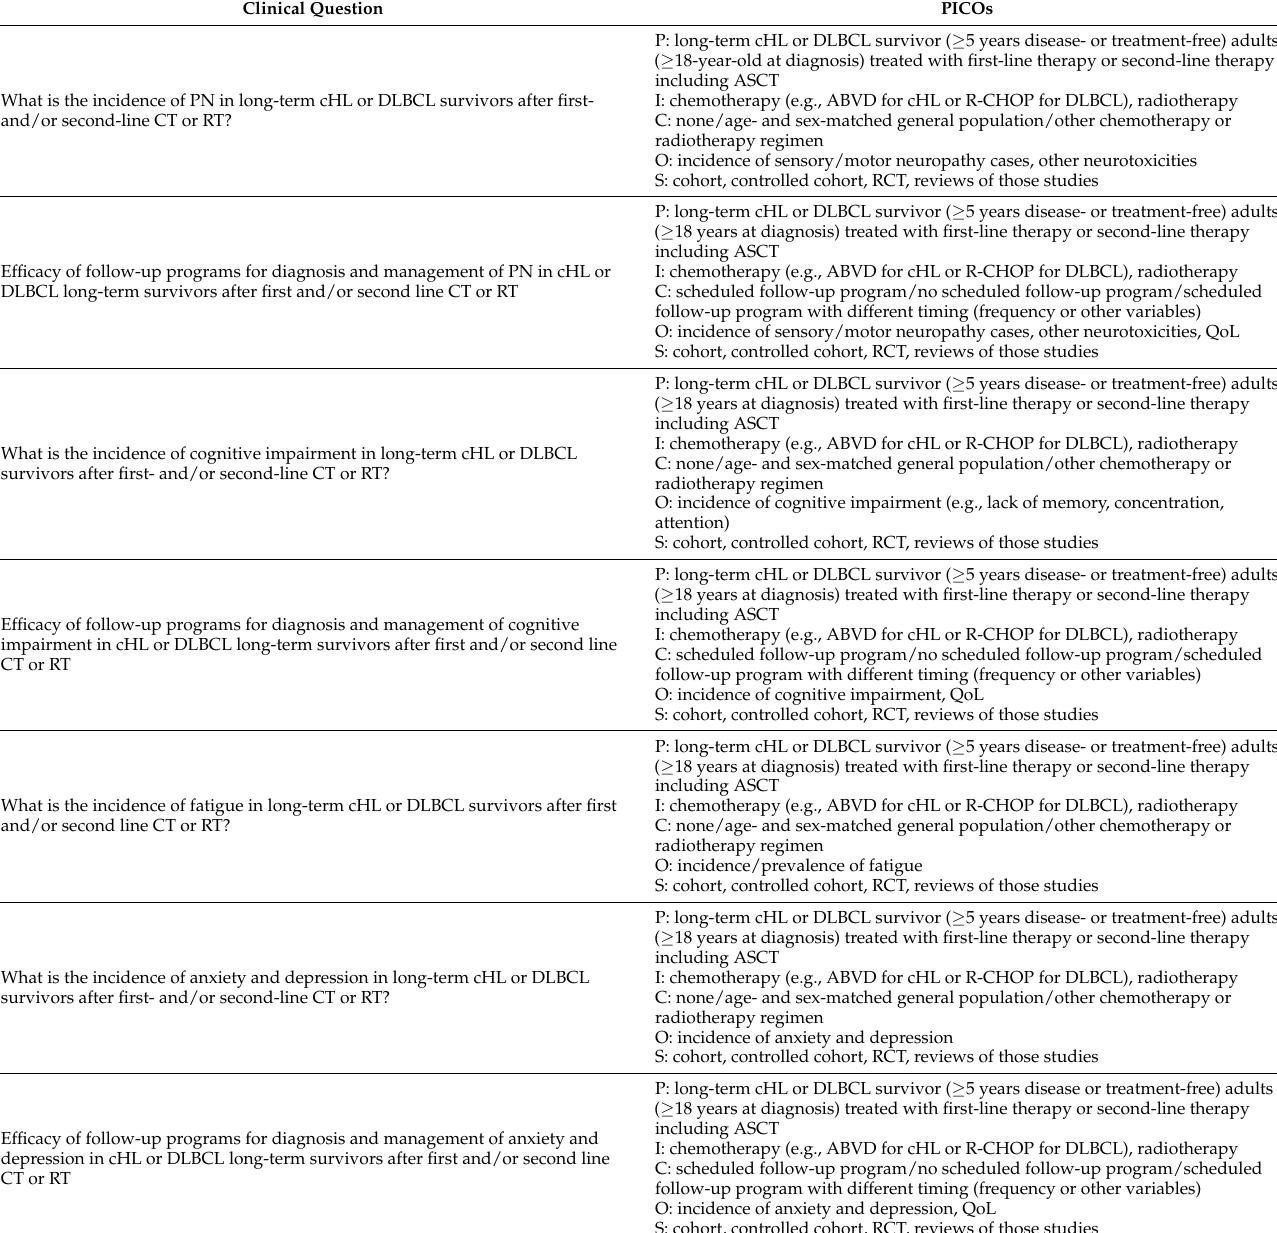
Table 1. Clinical questions and PICOs addressed by the review: neurological and mood